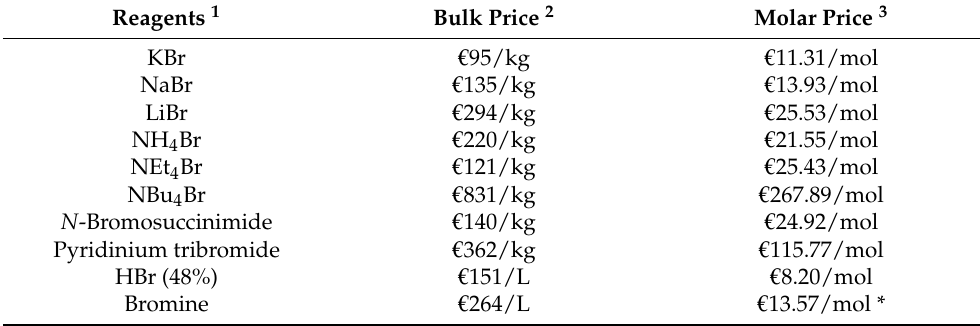
Table 1. Price comparison of bromide salts with classical brominating reagents